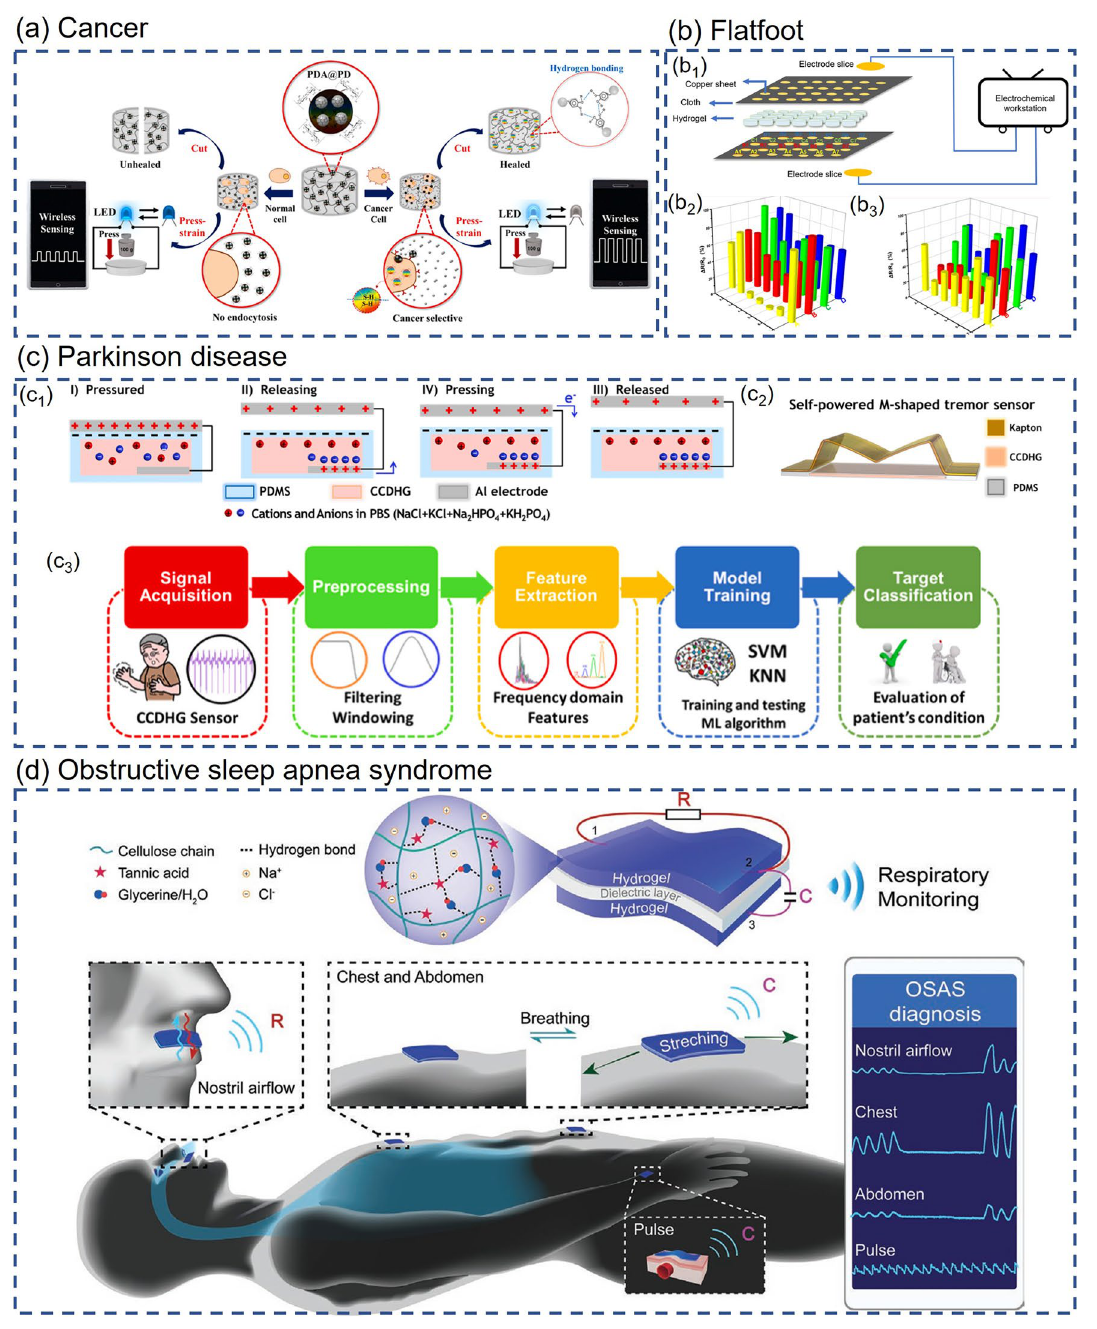
Fig. 12 a Cancer [199]. Schematic illustration of selective strain-pressure and cancer-mediated self-healing phenomenon of hydrogel-based sen- sor for cancer detection with real-time monitoring via smartphone. Reproduced with permission. Copyright 2021, Elsevier. b Flatfoot [162]. b 1 Schematic diagram of the hydrogel pressure sensor insole. The insole was divided into 28 areas, numbered A1–A7, B1–B7, C1–C7, and D1–D7, and copper sheets and hydrogels were placed in these areas to monitoring plantar pressure distribution. b 2 , b 3 Three-dimensional histograms of the relative resistance of hydrogel compressive sensor for monitoring the normal foot and flatfoot. Reproduced with permission. Copyright 2015, Elsevier. c Parkinson disease [201]. c 1 Working mechanism of CCDHG-TENG. c 2 Schematic image of self-powered M-shaped tremor sensor. c 3 Flow chart for evaluating condition of PD patient. Reproduced with permission. Copyright 2021, Elsevier. d Obstructive sleep apnea syndrome [202]. Schematic illustration of cellulose based hydrogel sensor with multimodal sensing capability for monitoring respiration. Reproduced with permission. Copyright 2022, John Wiley and